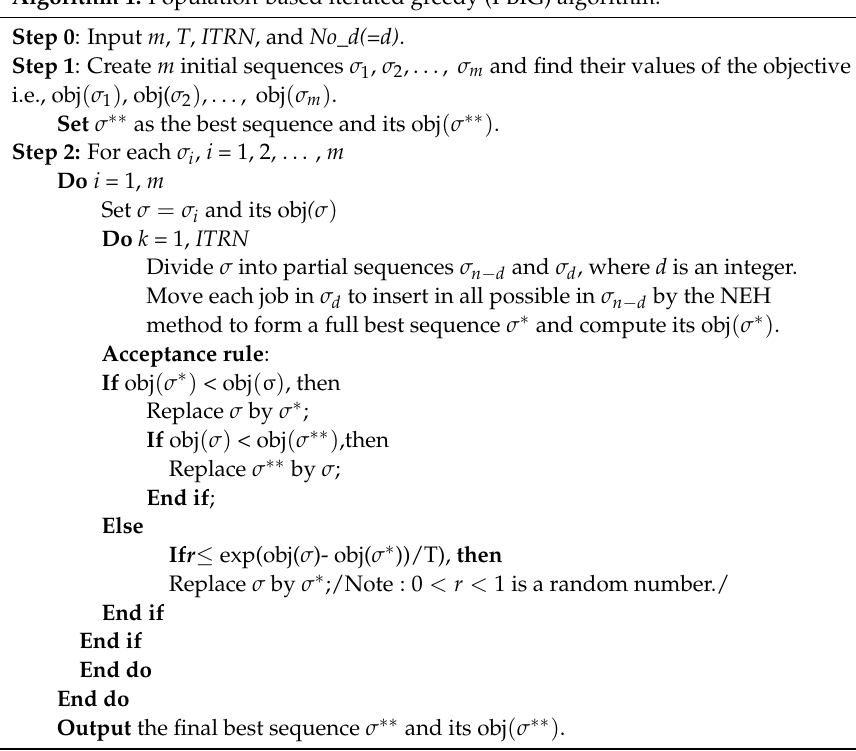
Algorithm 1: Population-based iterated greedy (PBIG)